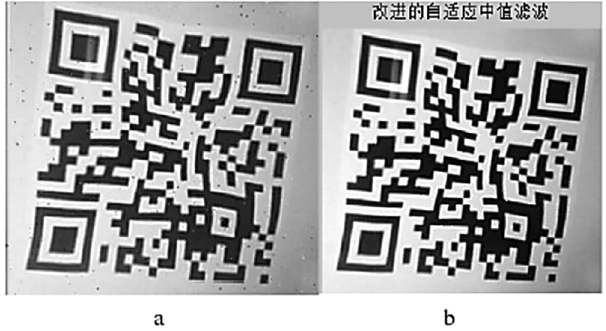
Figure 9: Comparison of e ff ect diagrams processed by the improved fi ltering algorithm: ( a ) Before fi ltering and ( b ) After applying improved fi ltering